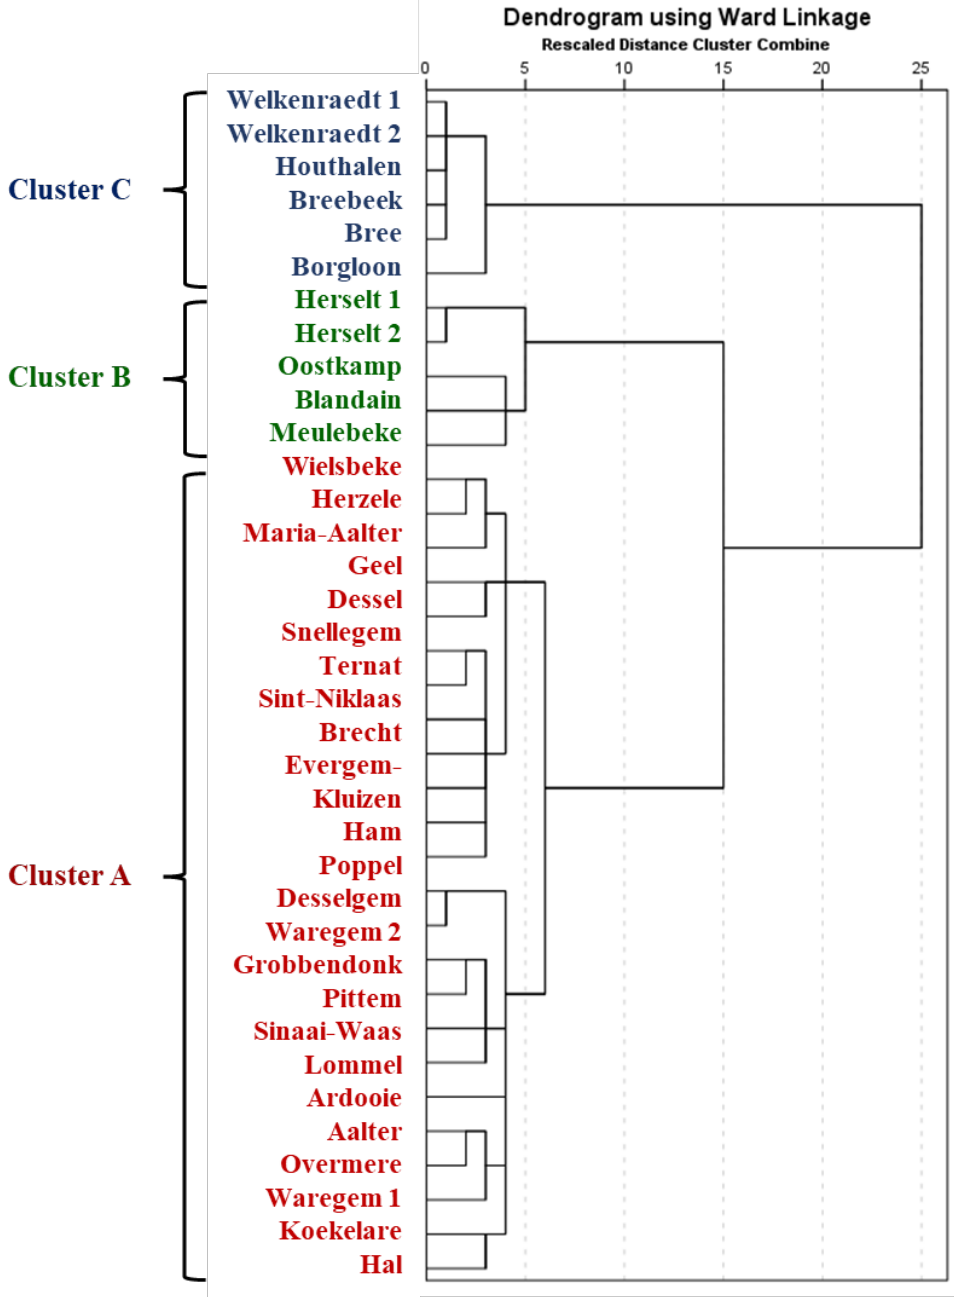
Figure 3. Dendrogram of 35 C. esculentus clonal populations clustered by Ward’s method based on the Jaccard distance matrix. Three clusters were retained (A, B, and C) based on genetic AFLP analysis.